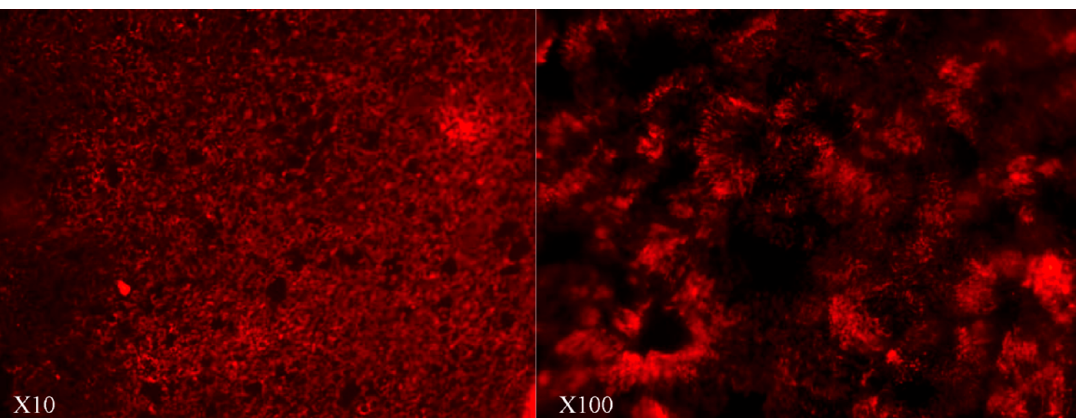
Figure 1. In vitro differentiation of human nasal epithelial cell in air–liquid interface culture. Immunostaining in transwell inserts after three weeks of culture (Day 21) using the anti- β IV tubulin monoclonal antibody (1/500) (Abcam ab-11315). Cilia of a differentiated epithelium are shown in red. (Confocal images: ×10 (left image) and ×100 (right image)): ciliated structures were clearly detected on the apical surface of the cells.